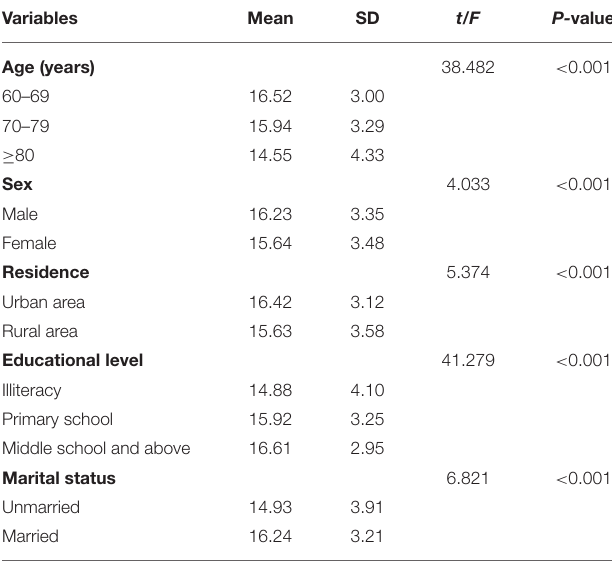
TABLE 6 | The status of C-BASIC-Q by different